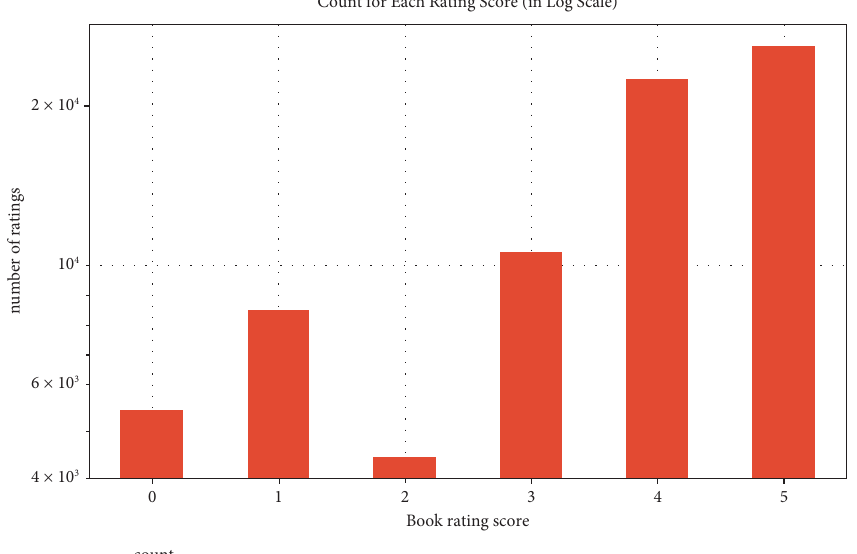
Figure 5: Te distribution of ratings before data preprocessing.